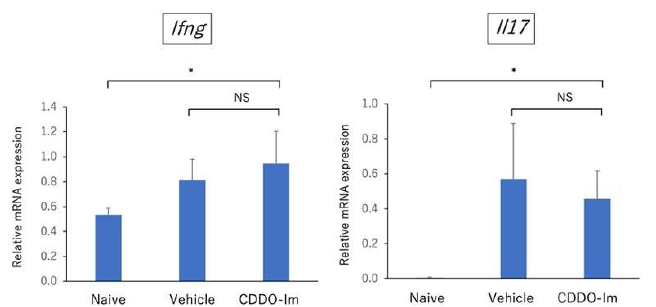
Figure 9. Quantitative PCR analysis of the gene expression of cytokines including Ifng and Il17 in draining lymph node cells in naïve mice (non-immunization), vehicle-treated mice and CDDO-Im-treated mice. Mice were immunized with IRBP peptide and vehicle or CDDO-Im was administered on days 0, 2, 4, 6, 8, 10, 12, and 14 after immunization, and draining lymph node cells were collected on day 21. The gene expression of Ifng and Il17 in draining lymph node cells was examined by quantitative PCR. The mean ± standard deviation for each group ( n = 5 mice per group) are shown. Asterisk indicates p < 0.05 versus CDDO-Im-treated mice. Statistical analysis was performed according to ANOVA followed by Bonferroni tests. NS: not significant.